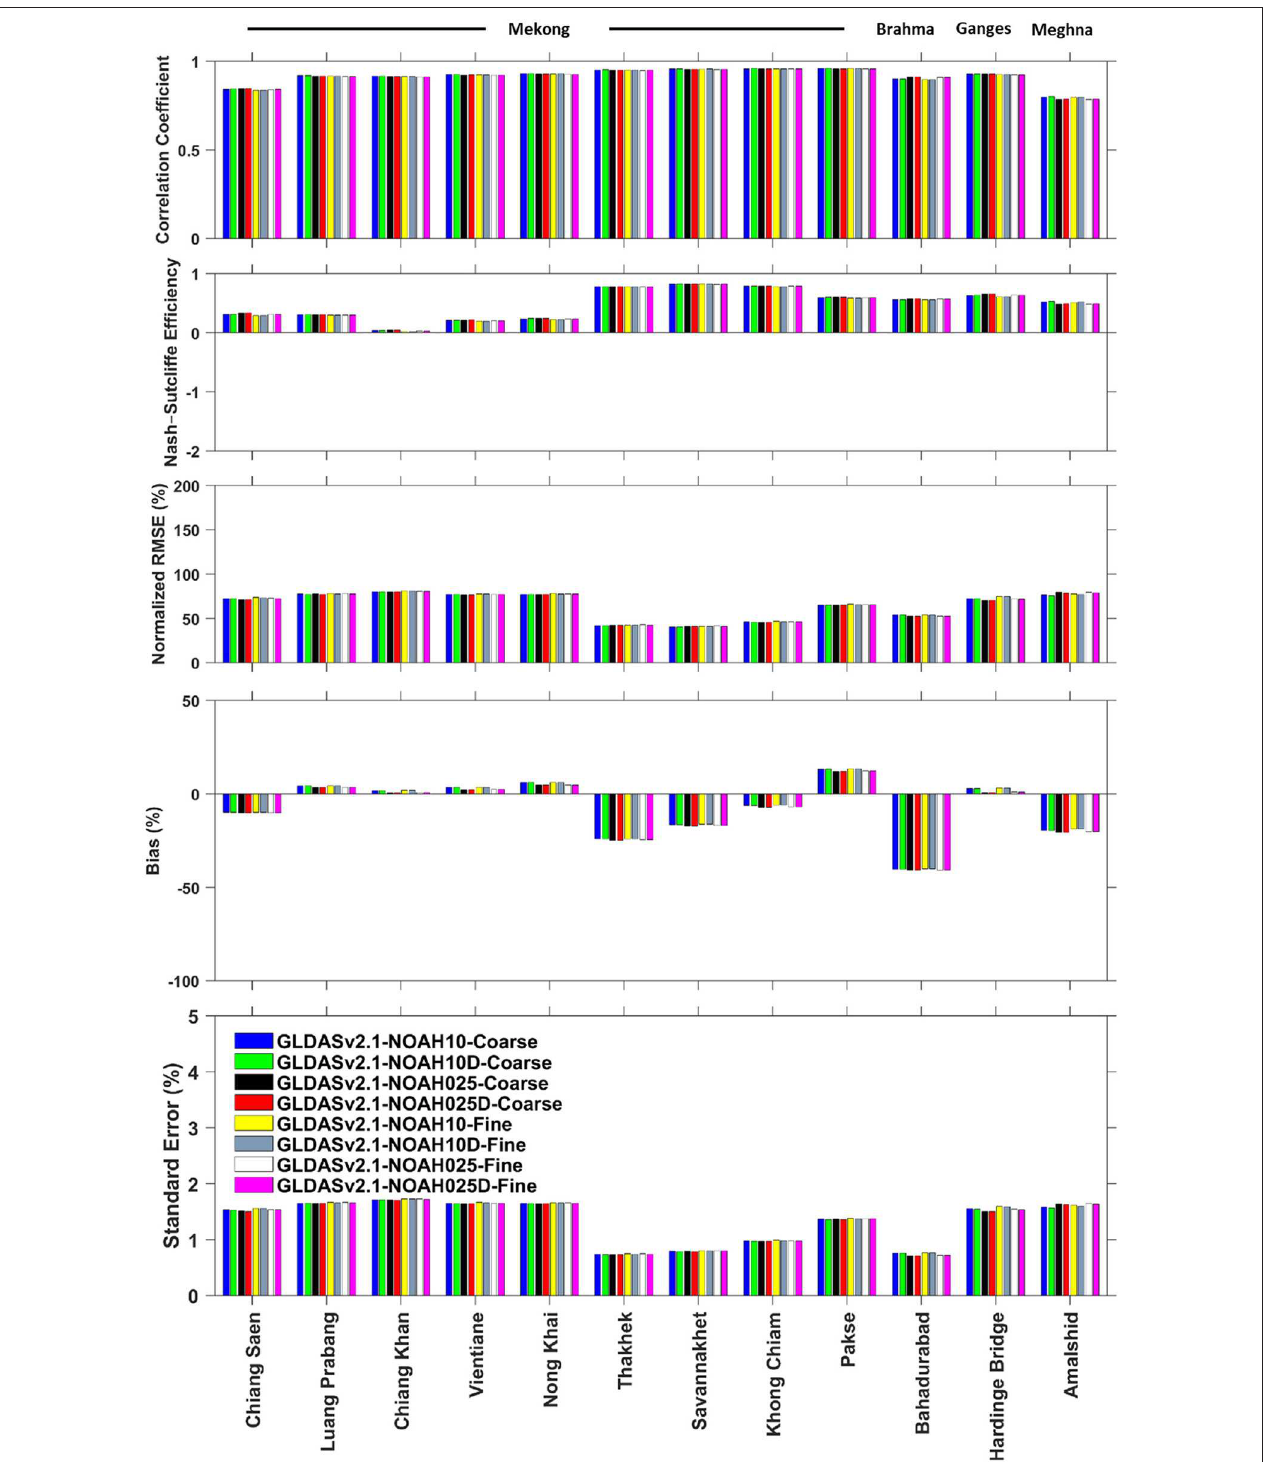
FIGURE 7 | Performance of simulated daily stream flow as a function of different spatio-temporal resolution of the same LSM using the same meteorological forcing (i.e., GLDASv2.1-NOAH). Here, NOAH10 and NOAH025 are for different spatial resolutions, 1 and 0.25 ◦ , respectively. The LSM outputs in daily scale, denoted here by “D,” and the other test cases (i.e., without “D”) are for 3-hourly LSM outputs. The last part of each test case name is representing the river network resolution ( Figure 1 ) used for flow routing.